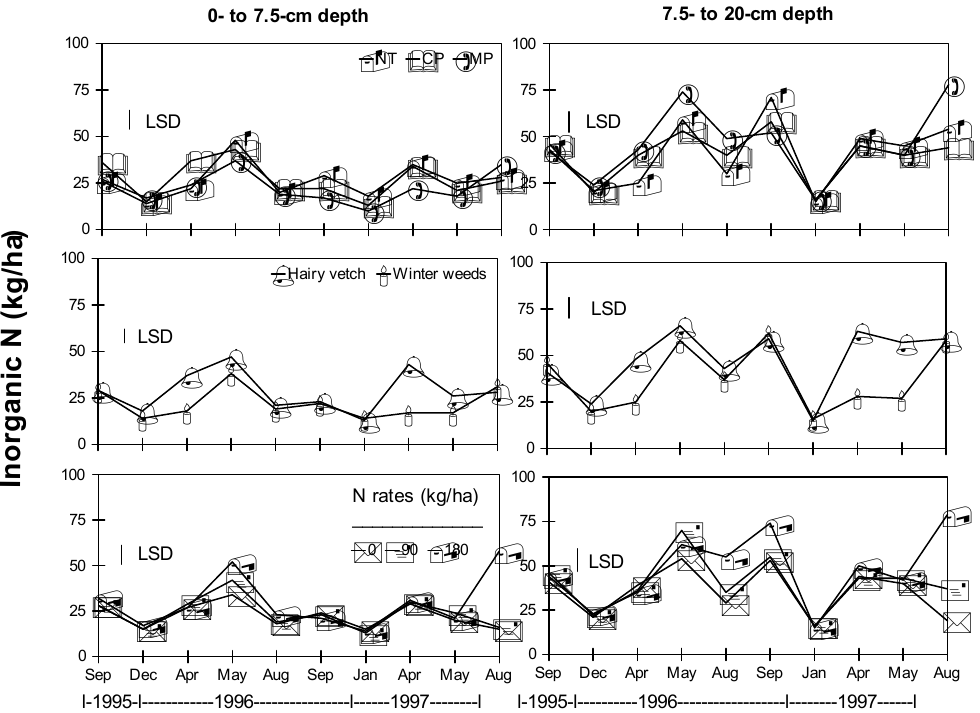
FIGURE 1. Soil inorganic (NH 4 + NO 3 ) content at 0- to 7.5- and 7.5- to 20.0-cm depths from September 1995 to August 1997 as influenced by tillage, cover crops, and N fertilization rates. NT denotes no-till; CP, chisel plowing; and MP, moldboard plowing. LSD is the least significant difference at p <